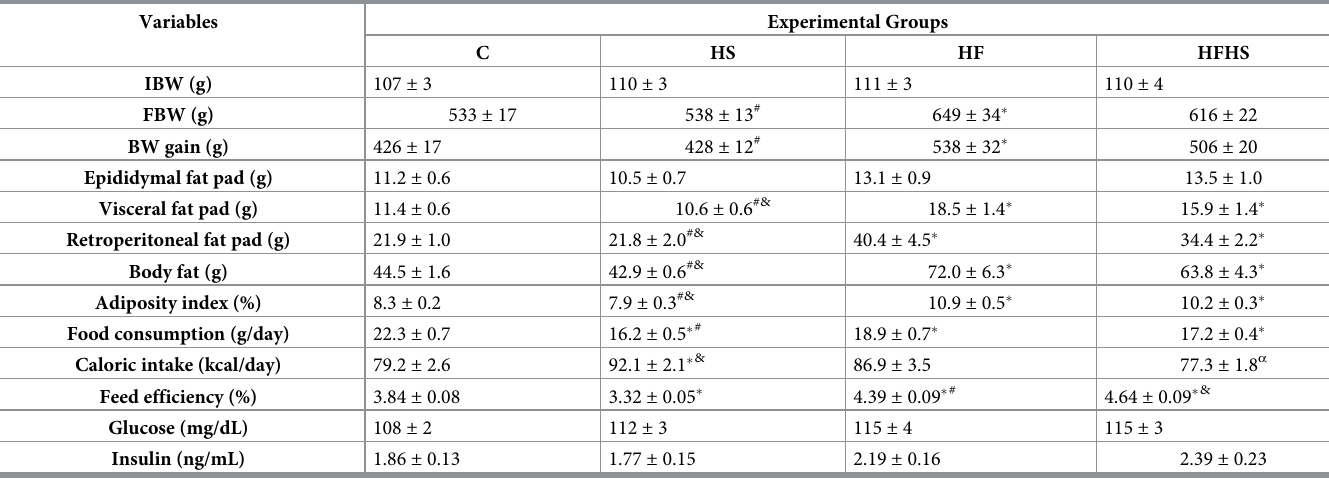
Table 2. General